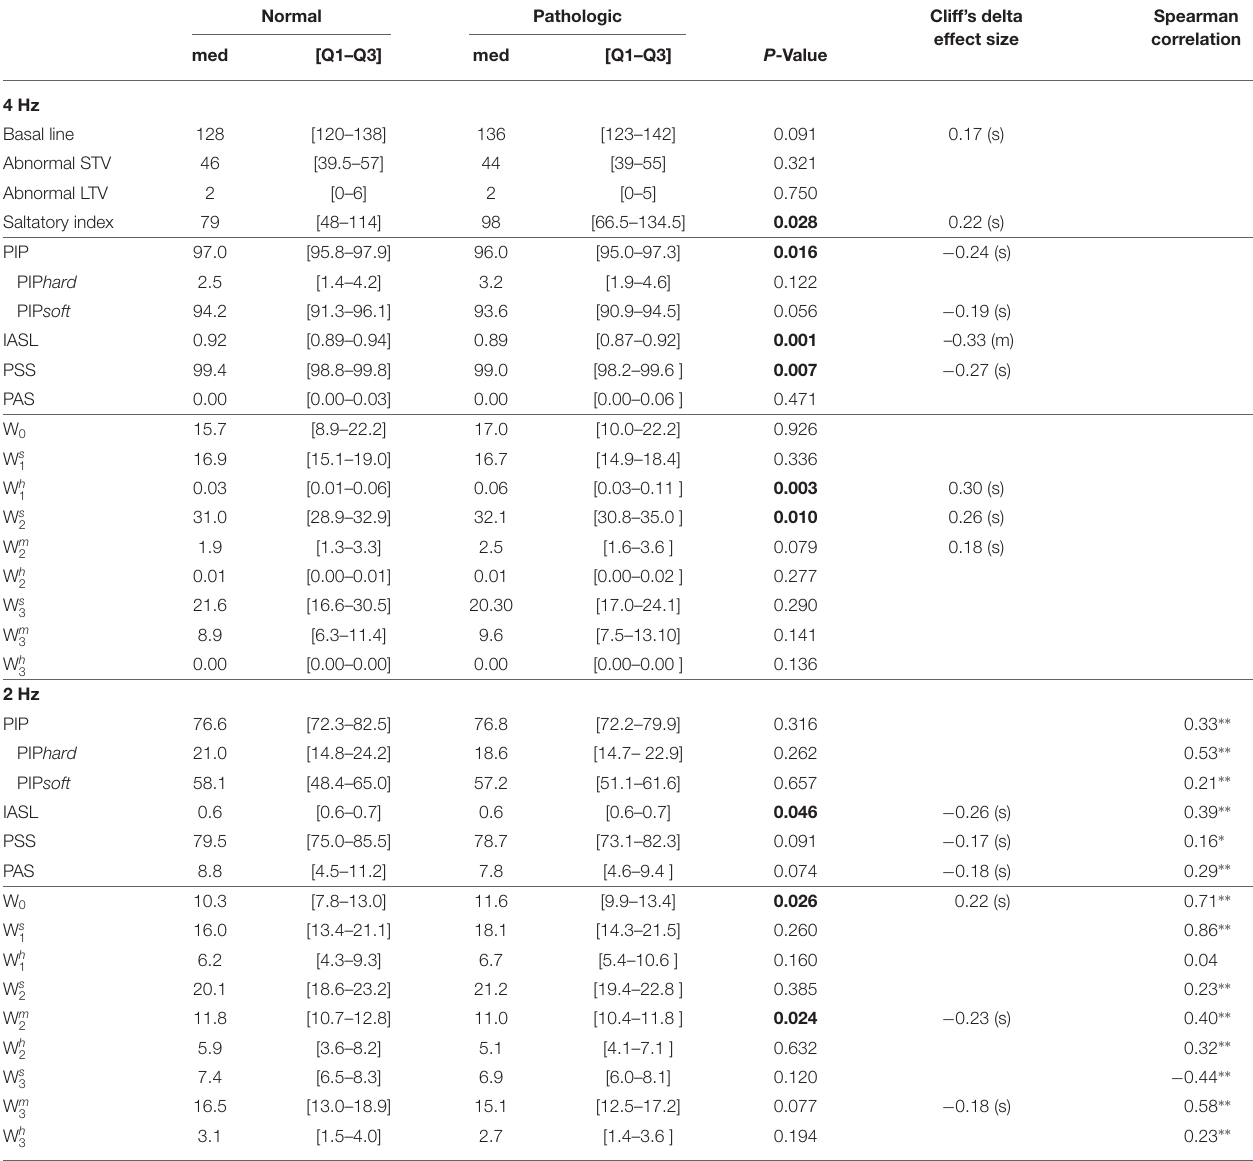
TABLE 2 | Comparison of fragmentation indices for both groups using Mann-Whitney U -test when analyzing the 4 Hz fetal heart rate time series.